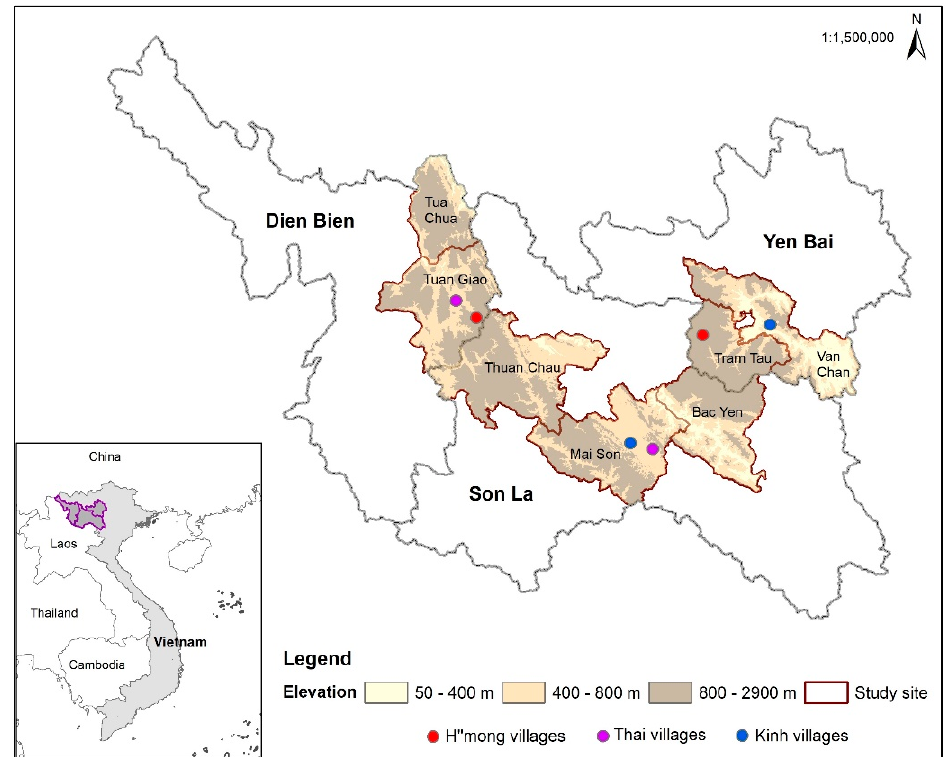
Figure 2. Map of the study villages within the Agroforestry for Livelihoods of Smallholder Famers in Northwest Viet Nam (AFLi) project site in northwest Viet Nam.